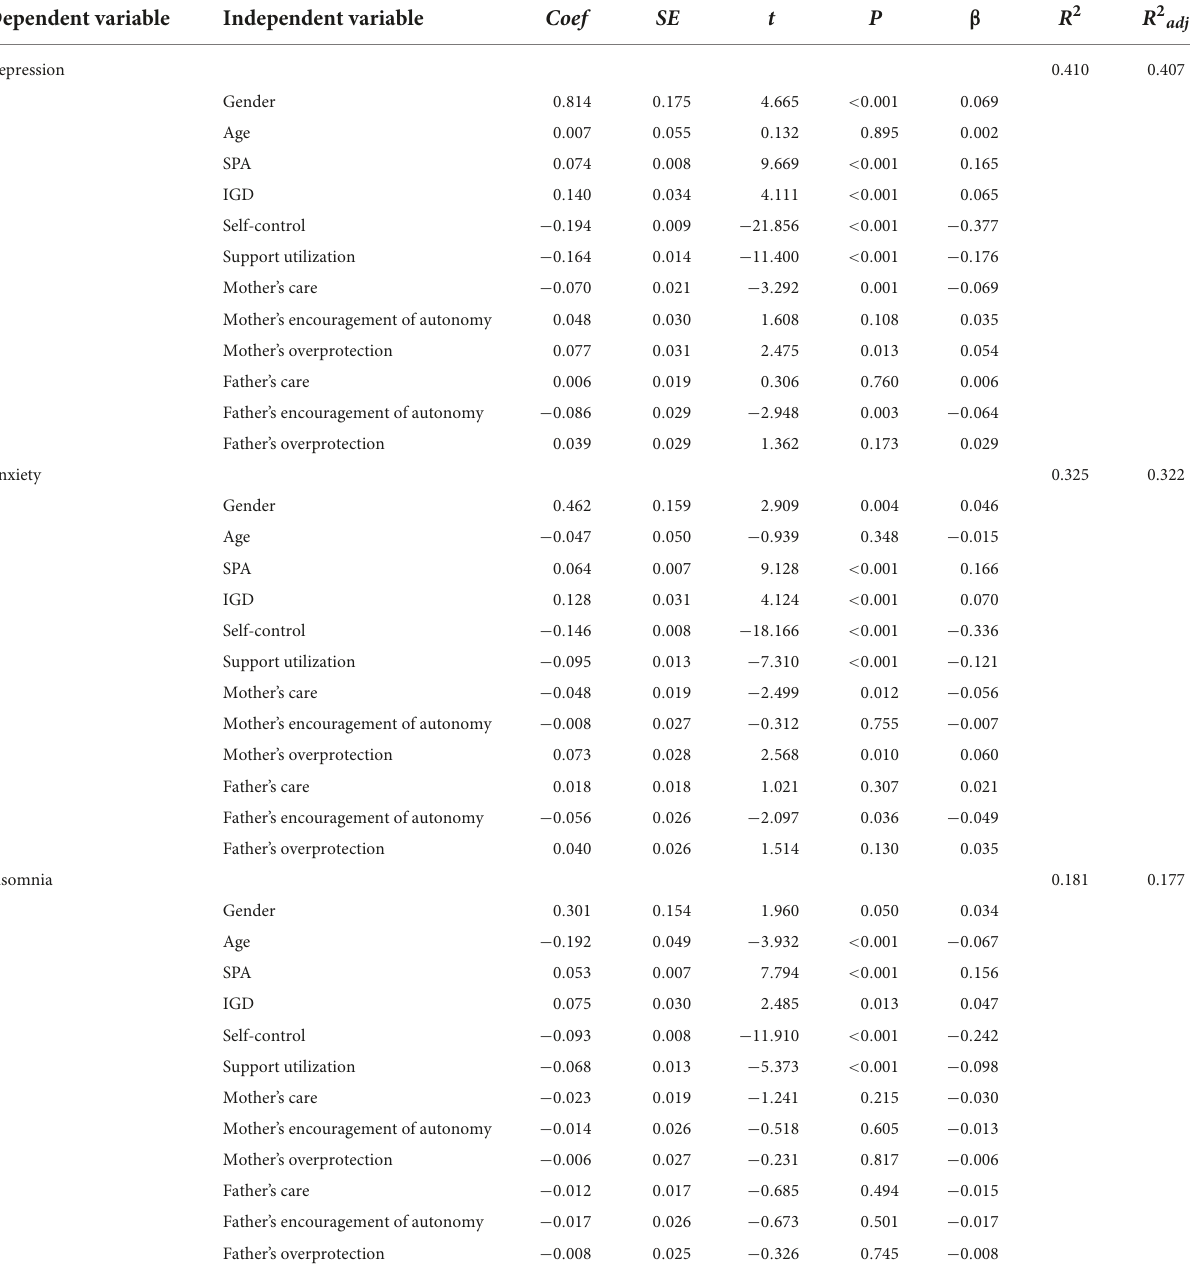
TABLE 4 Multiple regression analysis on depression, anxiety and insomnia ( n =